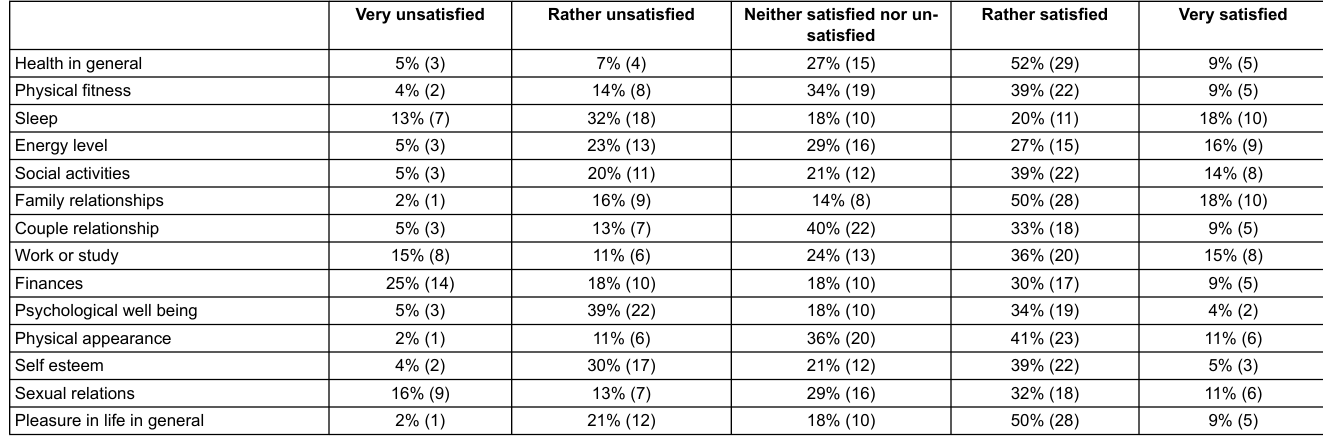
Table 3: Quality of life estimation at inclusion, % (n).